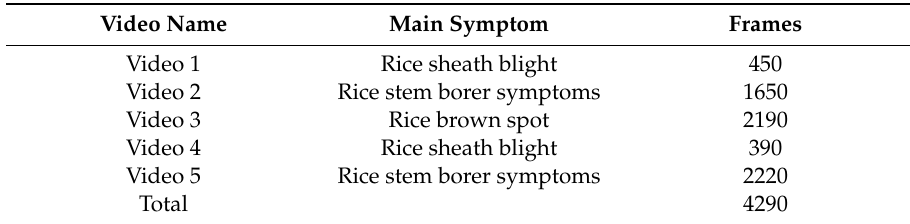
Table 2. Statistics of the videos in the dataset collected in China, 2018. The videos were only for detection. They did not participate in the model training. detection. They did not participate in the model training.